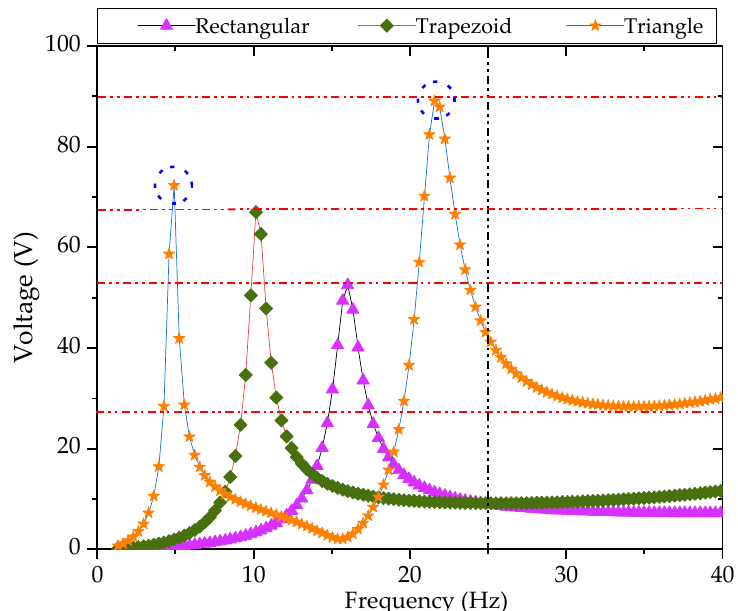
Figure 18. Simulation data of rectangular, trapezoidal, and triangular piezoelectrics [24].